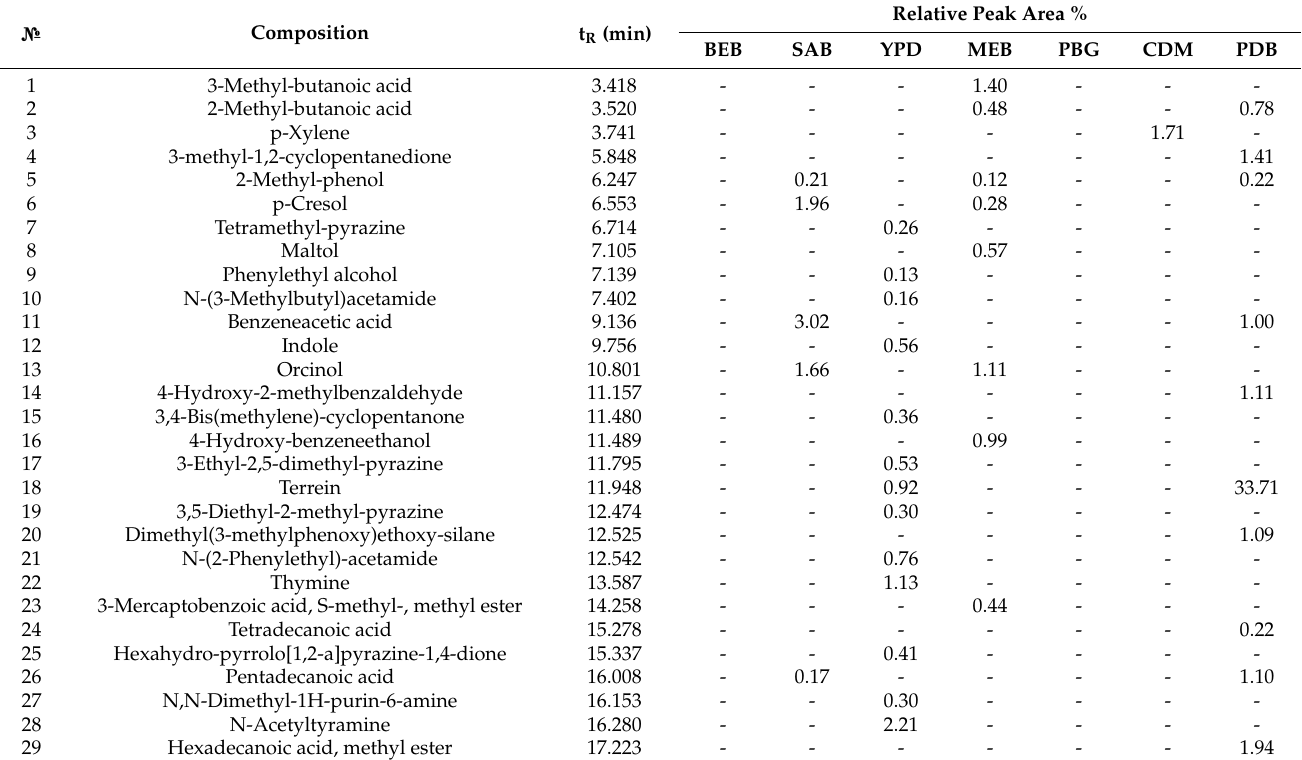
Table 7. The chemical composition of dichloromethane-ethyl acetate of the O. senegalensis NR-03. № Composition